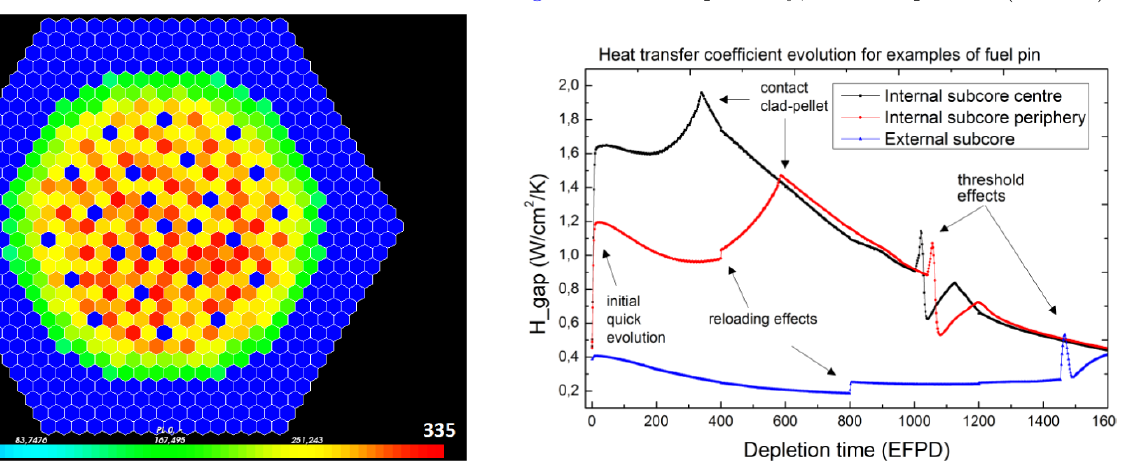
Fig. 4. Typical heat transfer coef fi cient evolution for chosen sub-assemblies (in top fi ssile